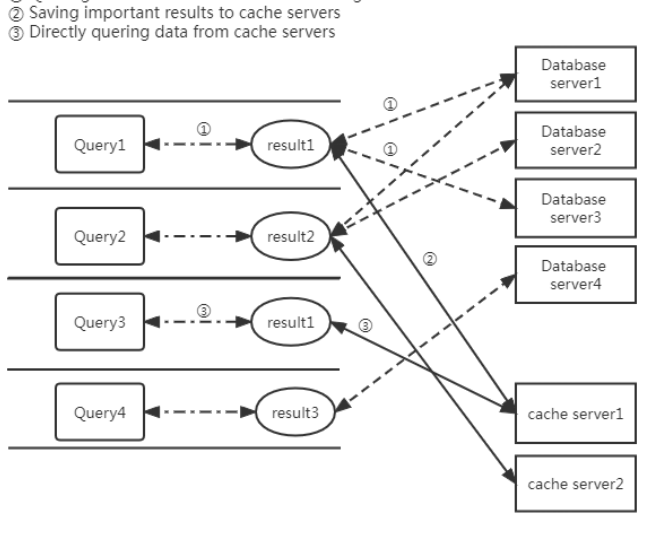
Figure 2. The process of quering